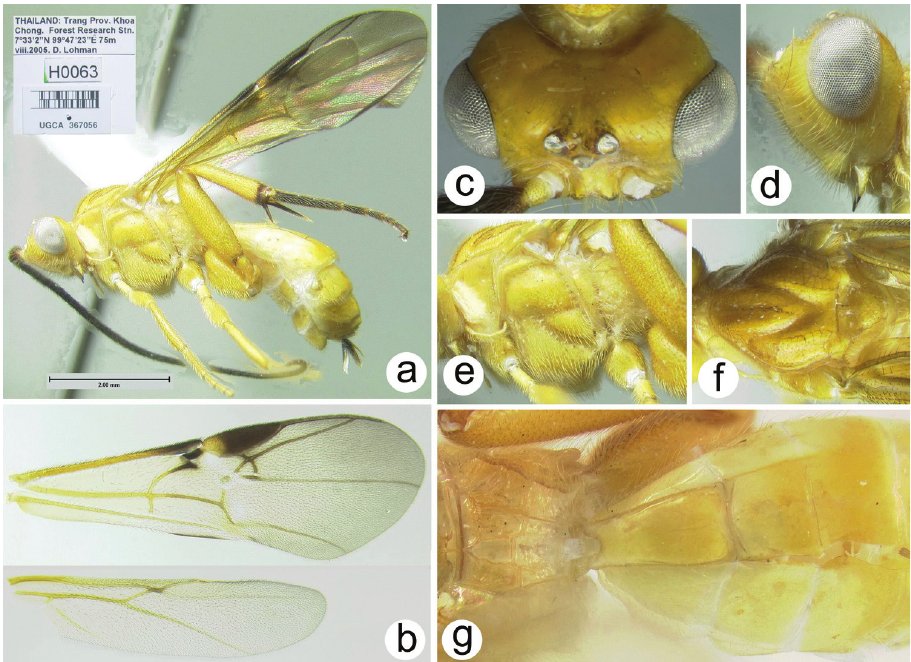
Figure 21. Zelodia wichaii sp.n. a lateral habitus b wings c dorsal head d lateral head e lateral mesosoma f dorsal mesosoma g dorsal propodeum and